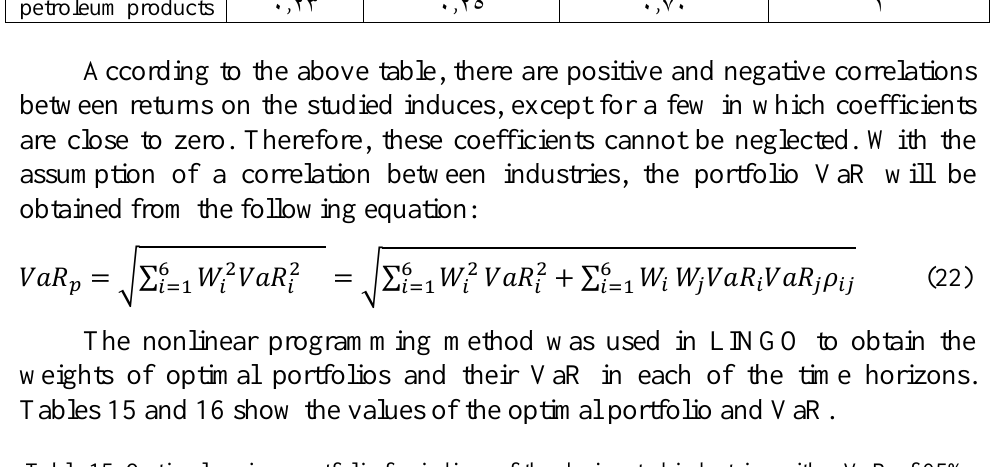
Table 15. Optimal regime portfolio for indices of the designated industries with a VaR of 95% investme metal chemical time nt products products horizon